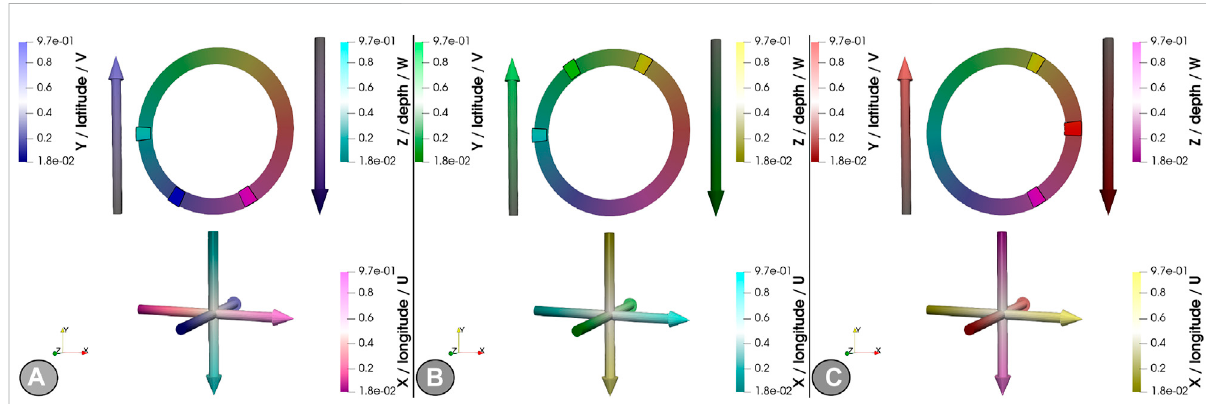
FIGURE 3 Representation oftheprimary,saturation-andvalue-modulatedperceptual mappingtovelocitymodeswithabluebase (A) ,greenbase (B) and red base (C) .